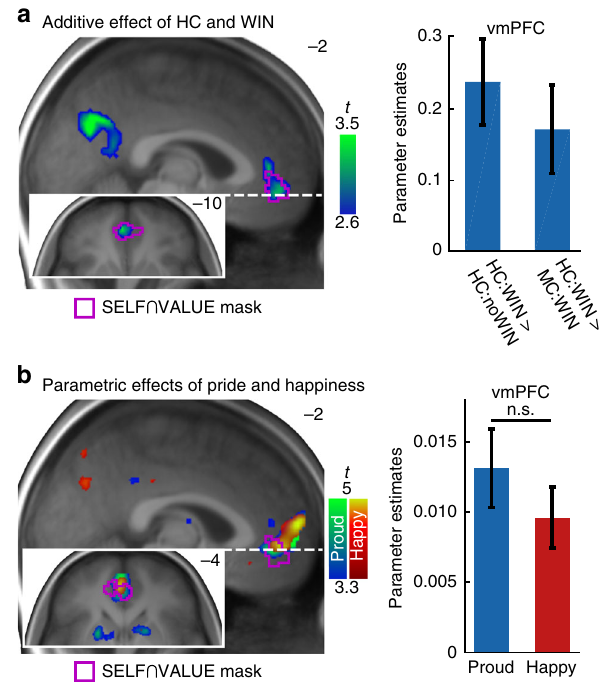
Fig. 5 Winning under high control and parametric effects of emotion. a Activations show the additive effect of success and control with the two- way conjunction [HC:WIN > HC:noWIN] ∩ [HC:WIN > MC:WIN] displayed at p < 0.005, uncorrected. The conjunction contrast survived small-volume FWE-correction at p < 0.05 inside the SELF ∩ VALUE mask in vmPFC. Barplot represents differences of neural activation in vmPFC between HC: WIN and the other two outcomes. b Parametric modulation effect of happiness (red – yellow) and pride ratings (blue – green) at outcome presentation, displayed at p < 0.001, uncorrected for illustrative purposes. Barplot shows group-level parameter estimates of the parametric modulations at the peak of each parametric effect inside the SELF ∩ VALUE mask. Violet outlines show SELF ∩ VALUE mask. Error bars are + / − 1 standard error of the mean. n.s. not signi fi cant. Source data are provided as a Source Data fi